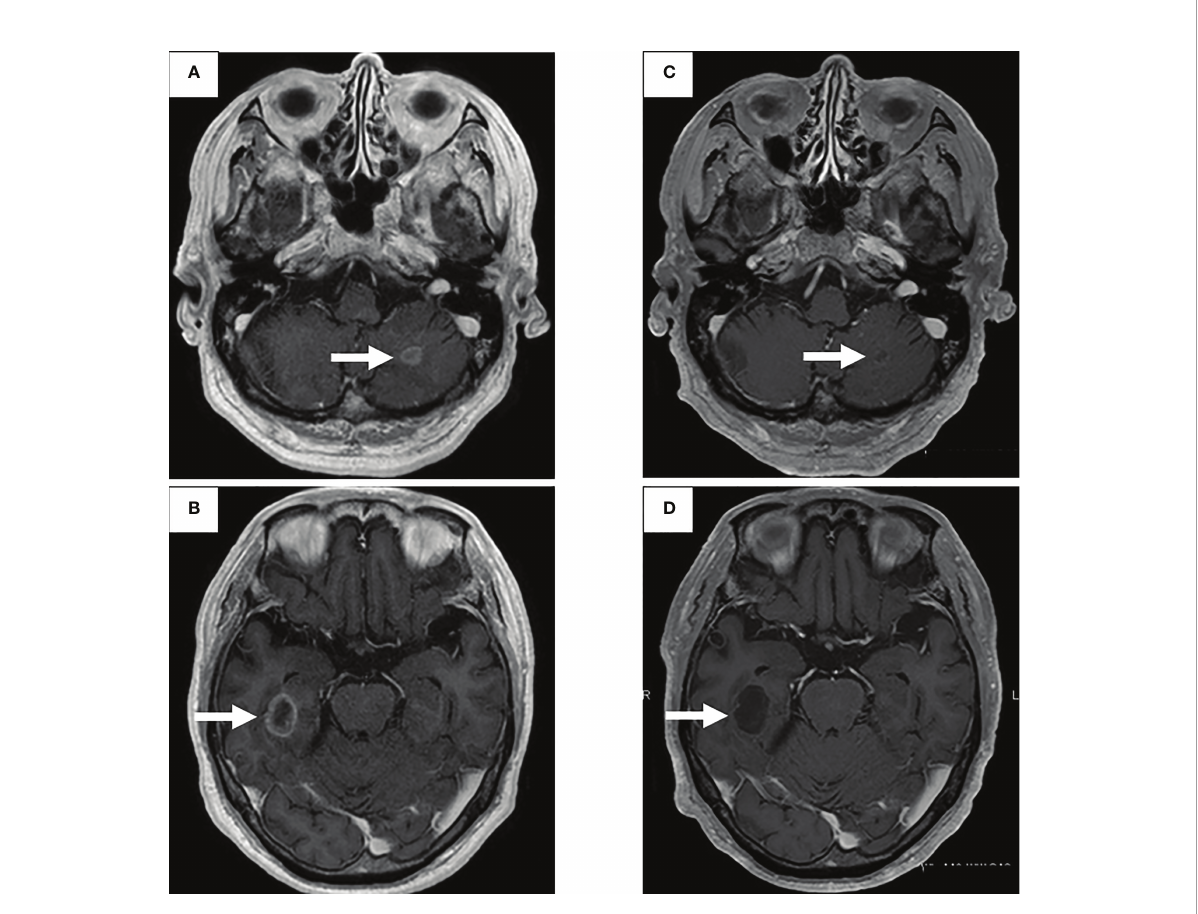
FIGURE 2 Therapeutic effect of brain metastasis using second-line treatment